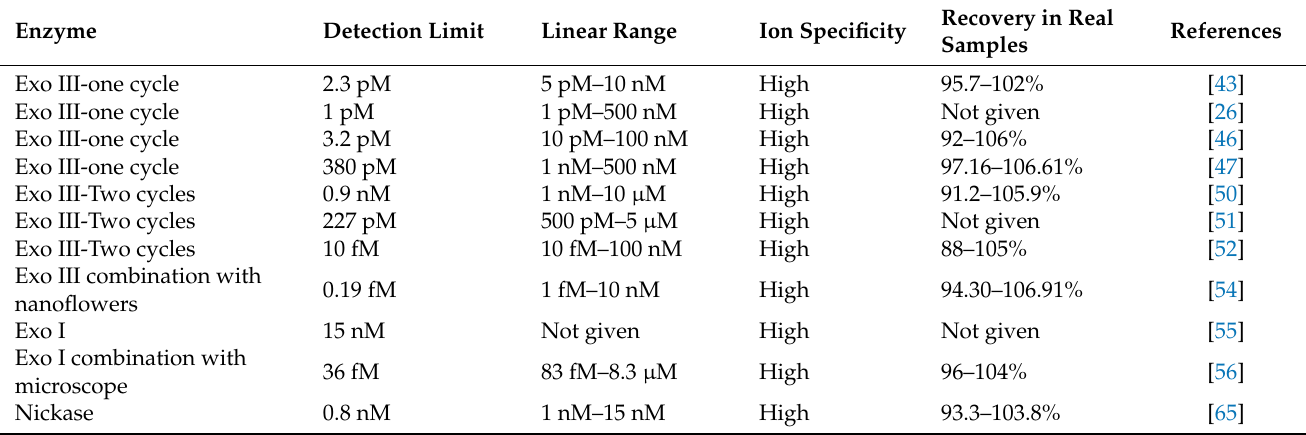
Table 2. Comparison of biosensors based on different enzymes for mercury